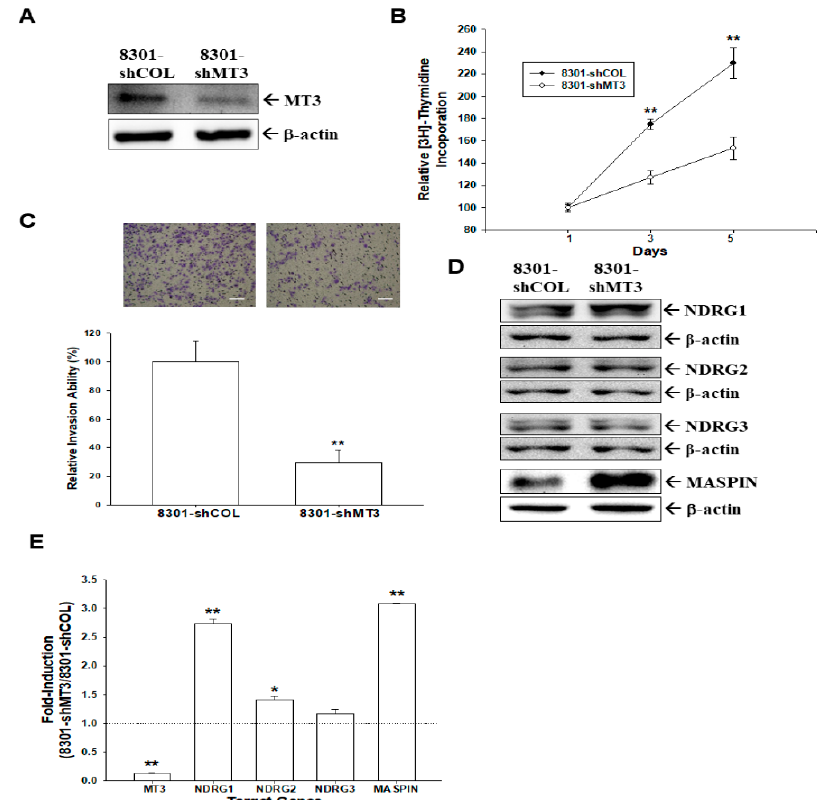
Figure 3. MT3 -knockdown enhances proliferation and invasion in TSGH-8301 cells. ( A ) Expressions of MT3 in mock-knockdown TSGH-8301 (8301-shCOL) and MT3 -knockdown TSGH-8301 (8301-shMT3) cells were determined by an immunoblot assay; ( B ) proliferation rates in 8301-shCOL ( • ) and 8301-shMT3 ( 〇 ) cells were determined by 3 H-thymidine incorporation assays (** p < 0.01). Each point on the curve represents the mean percentage (±SE, n = 6) relative to day 1; ( C ) invasion ability of cells was determined by in vitro Matrigel invasion assays (** p < 0.01). Data are presented as the mean percentage (±SE) of the invasion ability in relation to that of the 8301-shCOL cell group. The scale bar is 50 μ m. Expressions of NDRG1 , NDRG2 , NDRG3 , and MASPIN in 8301-shCOL and 8301-shMT3 cells were determined by immunoblot ( D ) and RT-qPCR ( E ) assays (* p < 0.05, ** p < 0.01).